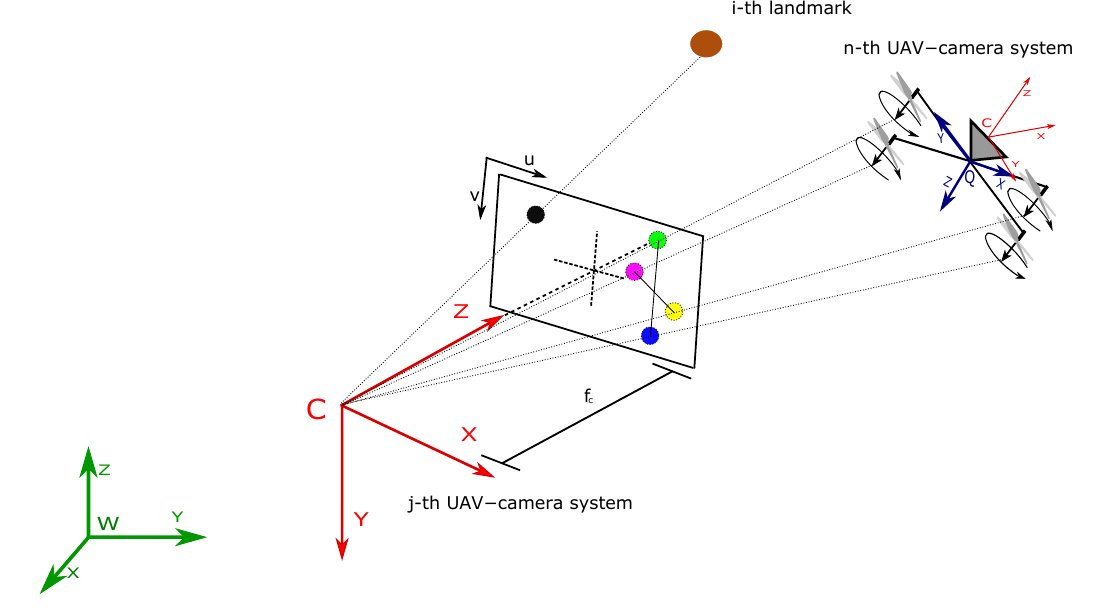
Figure 3. Pinhole camera projection